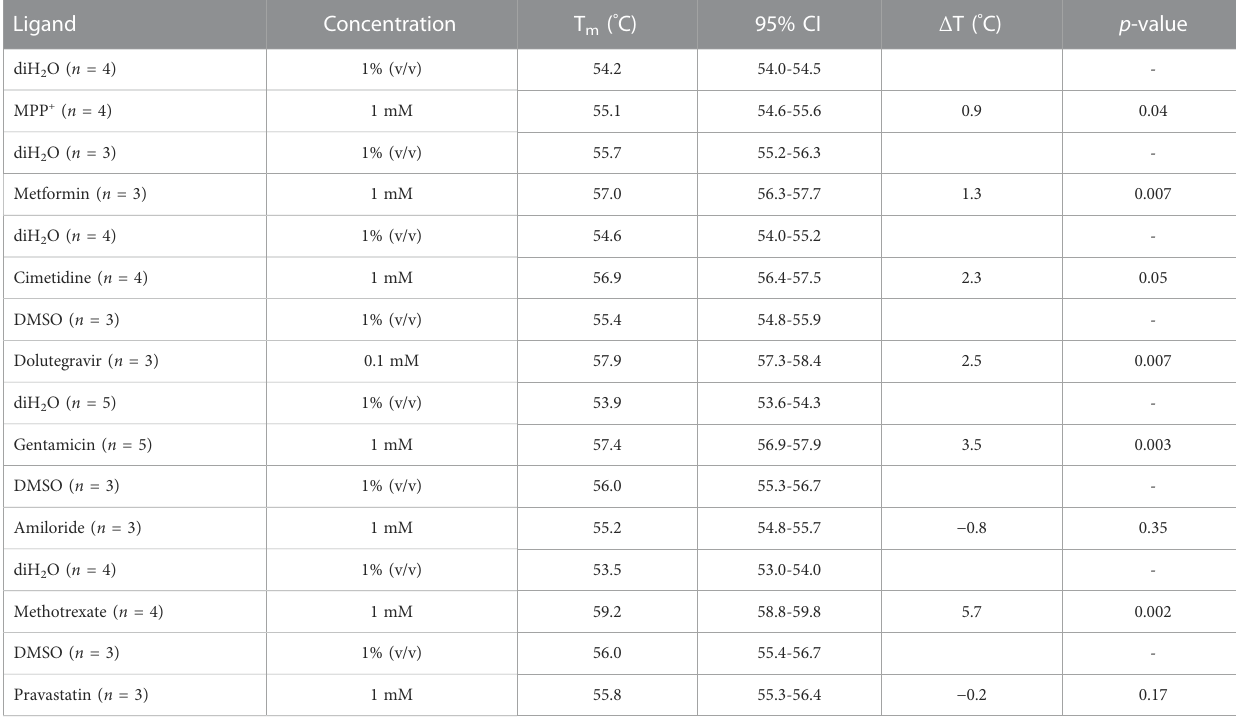
TABLE 1 Summary of OCT2 melting curves. Ligand